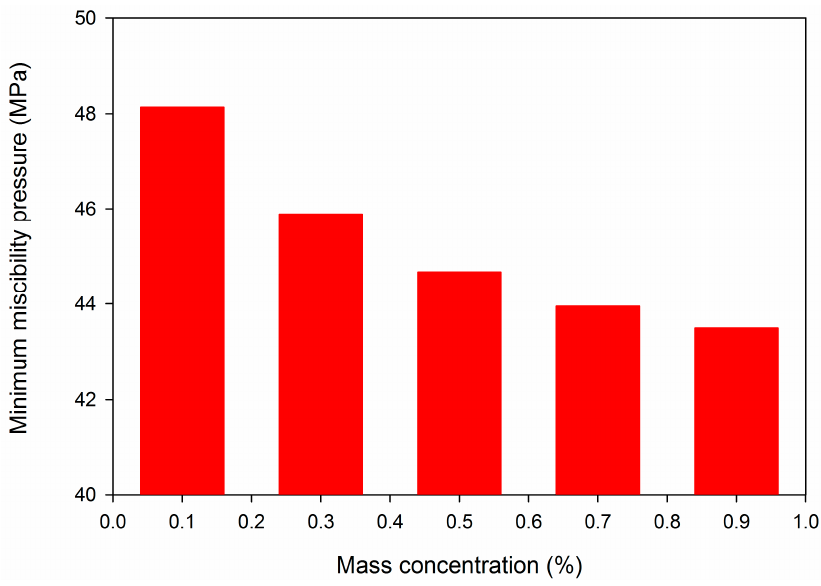
Figure 12. CO 2 –oil MMPs for the crude oil diluted with different mass concentrations of petroleum ether in the boiling range of 30 ‒ 60 °C.